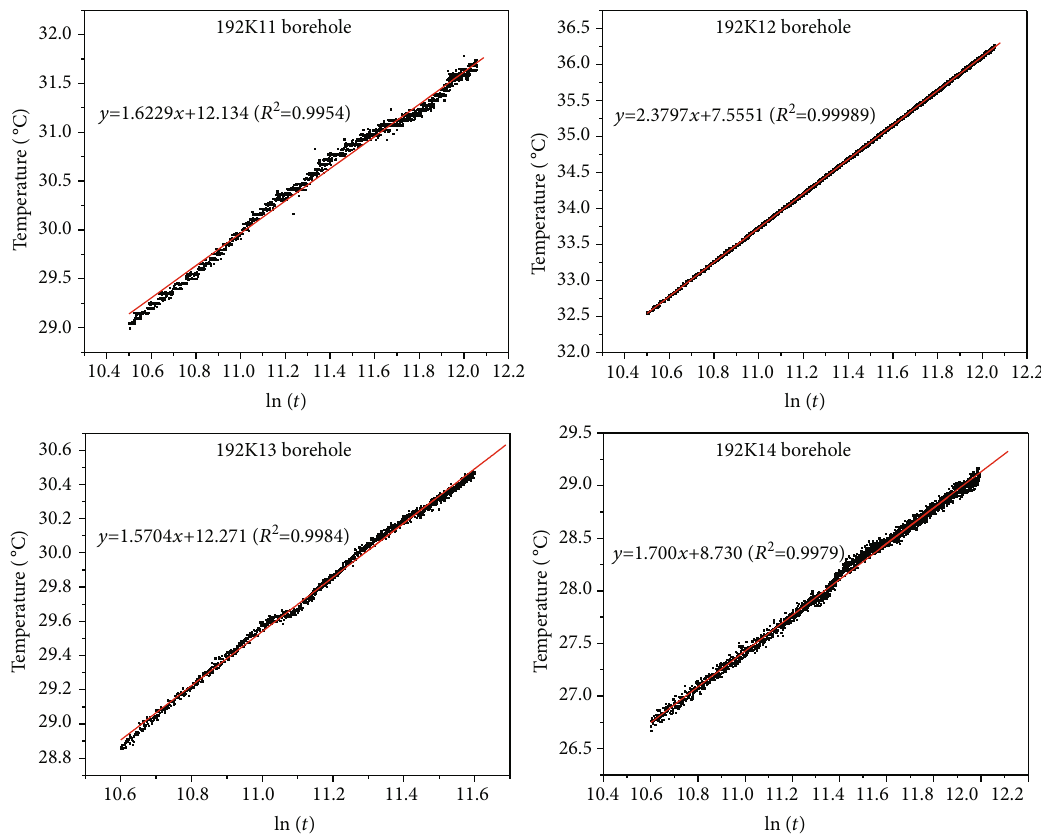
ln ð t Þ in four geothermal test f with